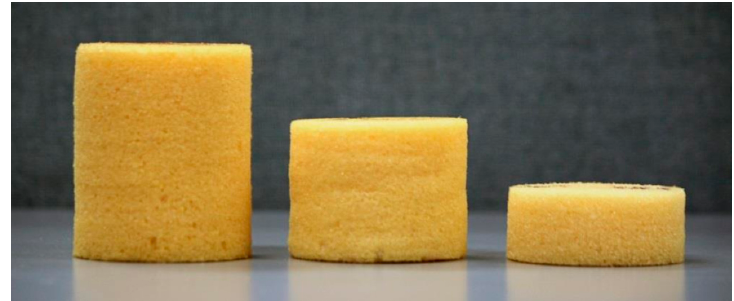
Figure 1. Foam cylinders after one, two, and three dynamic compressions.